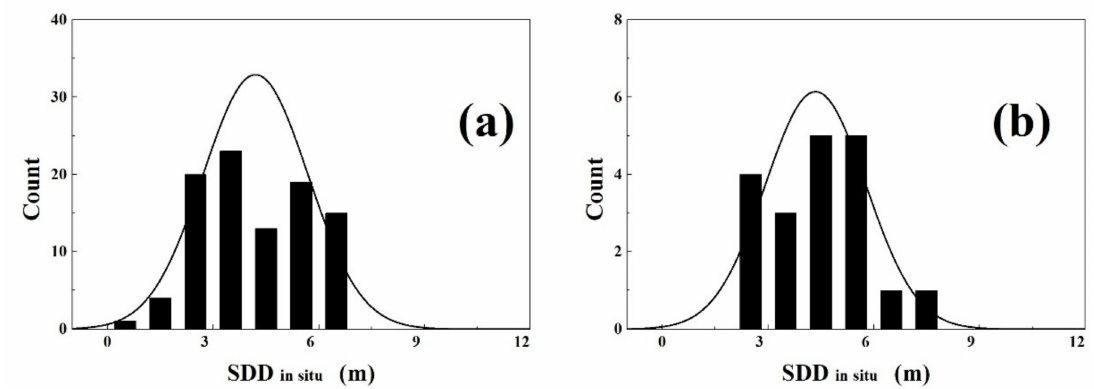
Figure 3. Histogram distribution of the modeling ( a ) and validation ( b ) SDD